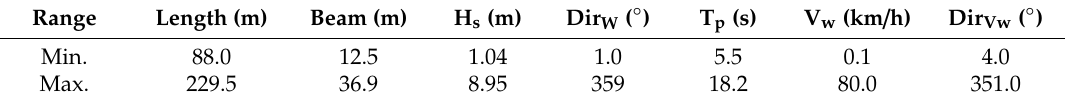
Table 3. Range of the variables considered for the calculation of the transfer functions. Range